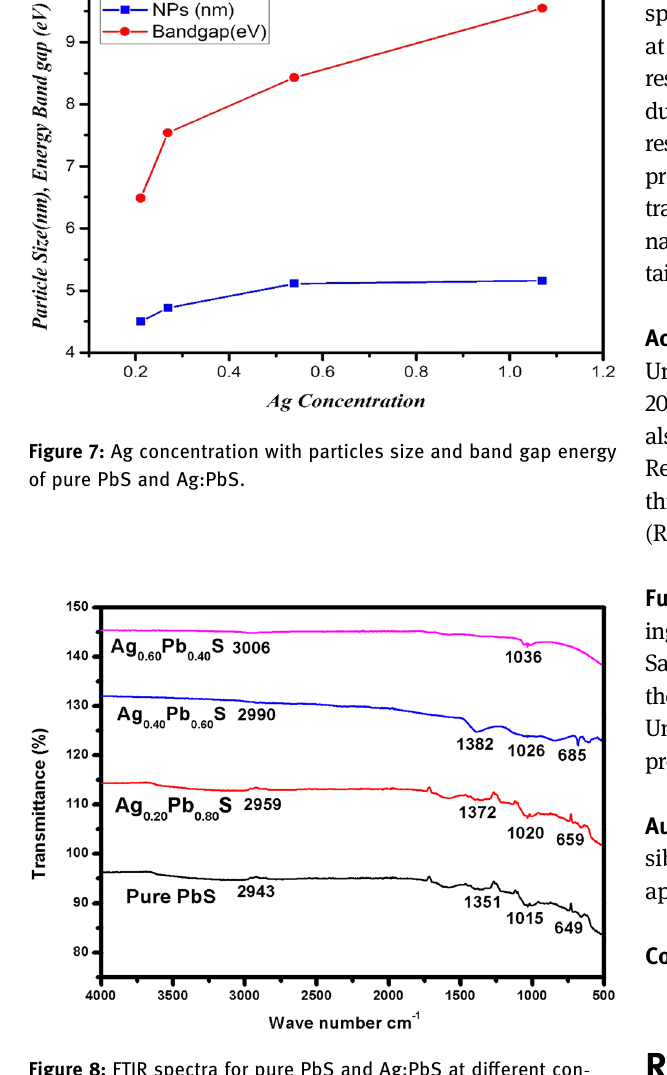
Figure 8: FTIR spectra for pure PbS and Ag:PbS at di ff erent con - centrations: ( a ) 20%, ( b ) 40%, and ( c ) 60%.